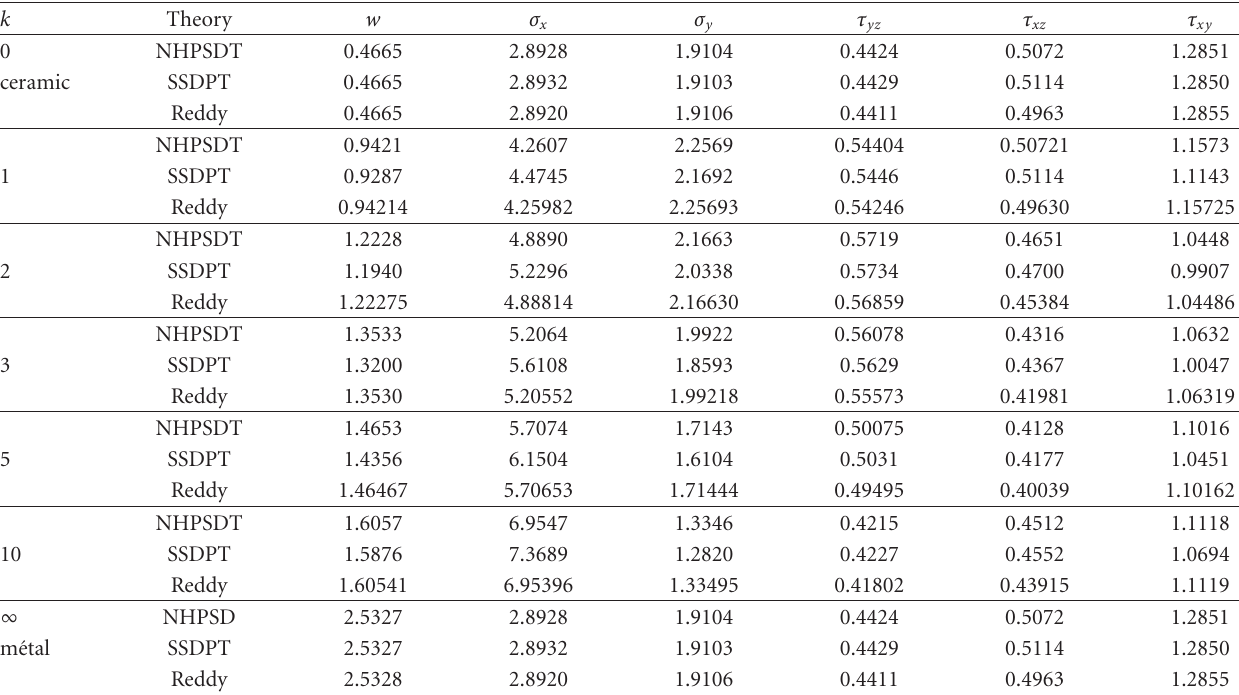
Table 4: E ff ects of volume fraction exponent and loading on the dimensionless stresses and displacements of a FGM square plate ( a/h = 10).